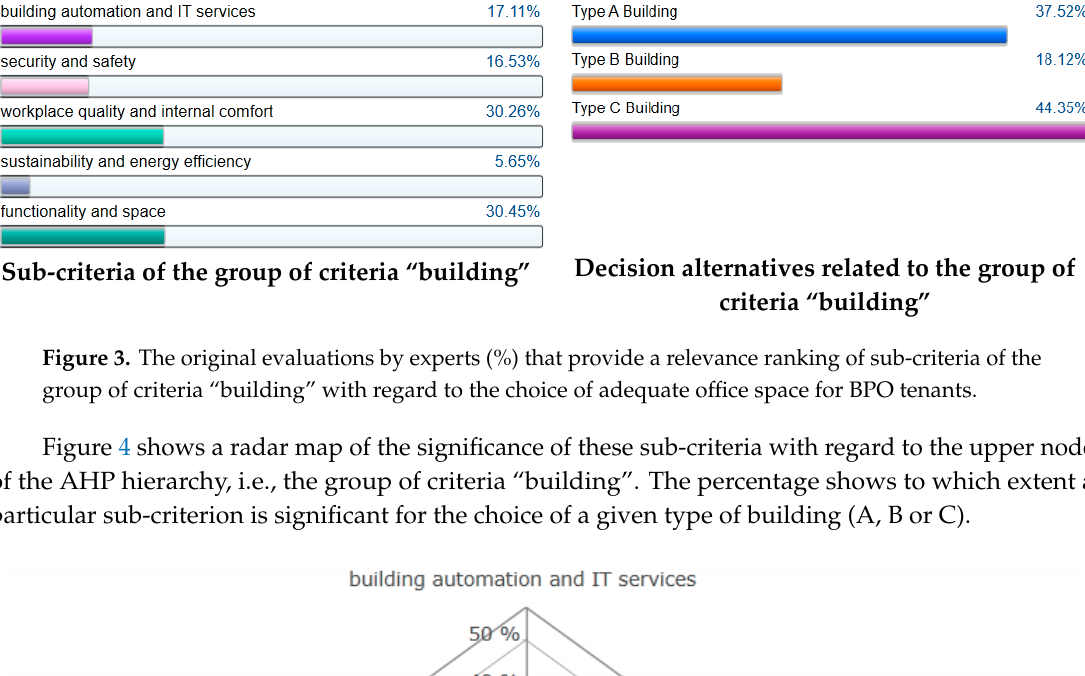
Figure 4. The hierarchy of decision alternatives (criteria sensitive, %).